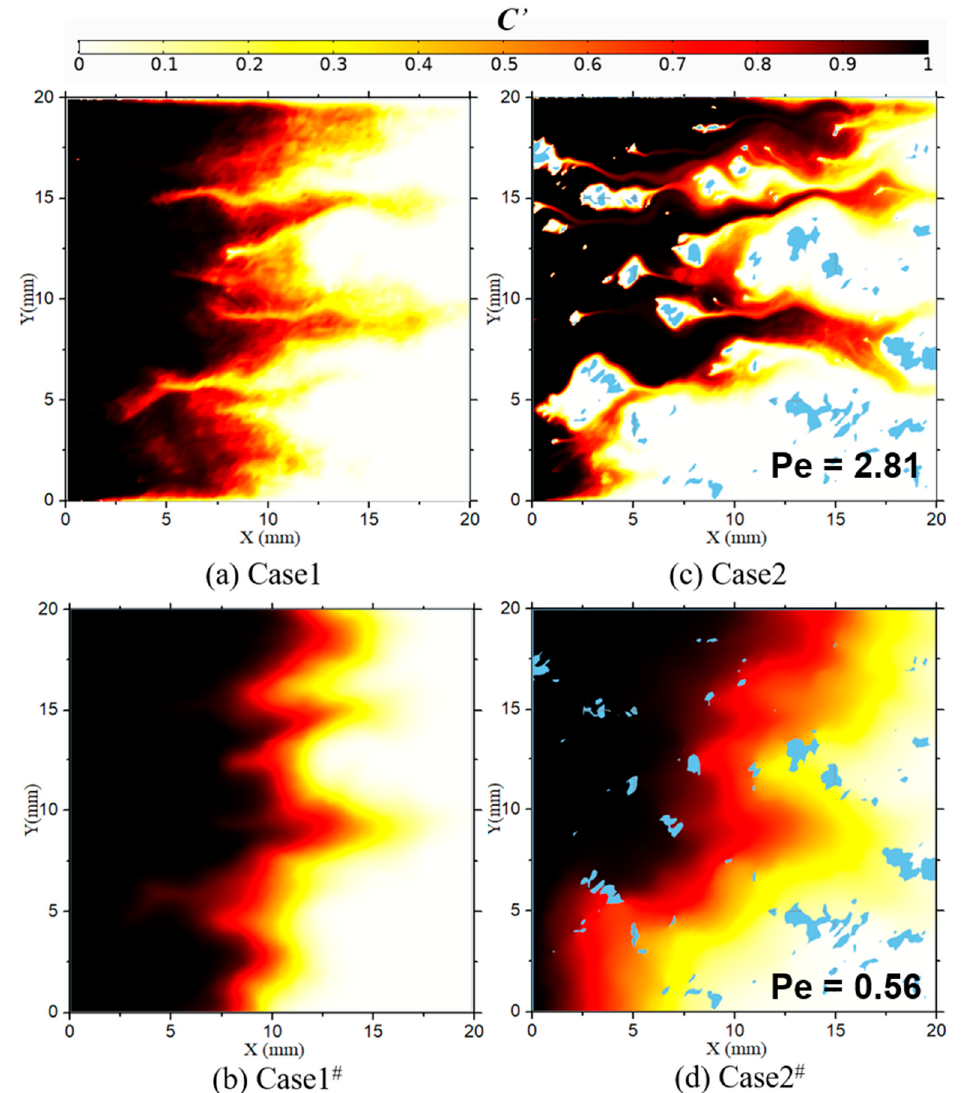
Figure 9. Comparisons of the concentration distribution in di ff erent cases for H = 0.50 at pore volume ( PV ) = 0.6. ( a ) Case1: ∆ u = 0.00 mm, without di ff usion process; ( b ) Case1 # : ∆ u = 0.00 mm, with di ff usion process; ( c ) Case2: ∆ u = 0.20 mm, without di ff usion process; ( d ) Case2 # : ∆ u = 0.20 mm, with di ff usion process.